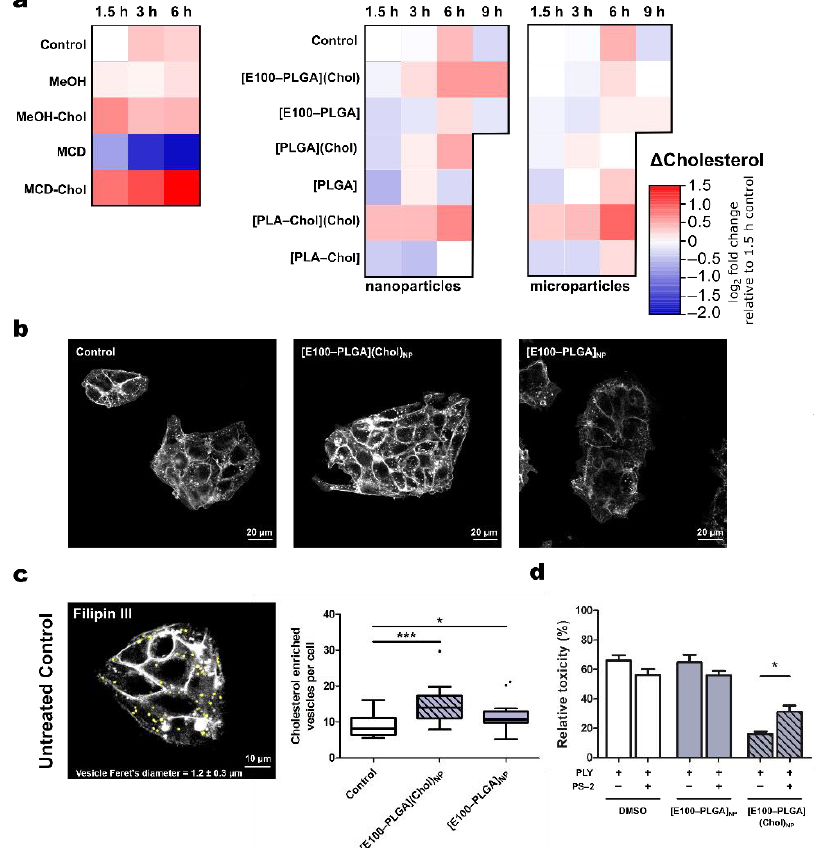
Figure 2. Intracellular delivery of cholesterol by polymeric particles. ( a ) HepG2 cells were treated with (50 µg mL −1 ) polymeric particles prepared by nano- and microprecipitation, or equimolar amounts of cholesterol dissolved in methanol (MeOH) or methyl- β -cyclodextrin (MCD) in DMEM:F12. The change in cellular un-esterified cholesterol is depicted as log 2 -fold relative to the cholesterol level of untreated control cells at 1.5 h; means and standard deviations are provided in Supplementary Table S3. ( b ) Distribution of cholesterol was assessed by fluorescence microscopy of filipin III stained HepG2 cells following 1.5 h stimulation with [E100 – PLGA](Chol) NP and [E100 – PLGA] NP . The contrast has been adjusted equally on the depicted images for better visualization. Staining intensity does not reflect cholesterol levels as measured by mass spectrometry. ( c ) Cholesterol-rich vesicles (yellow dots) were identified in proximity to the plasma membrane by thresholding filipin III fluorescence images. The number of cholesterol-containing vesicles per cell was calculated after cell nuclei were counted. Feret ’ s diameter of the identified vesicles was examined by applying the analyzed particle function in the Fiji distribution of ImageJ. Supplemen- tation of the nanocarrier significantly increases the number of cholesterol-rich vesicles per cell, as shown in Tukey’s box plot. ( d ) Inhibition of cellular uptake by 25 µ mol L − 1 PitStop-2 (PS-2)